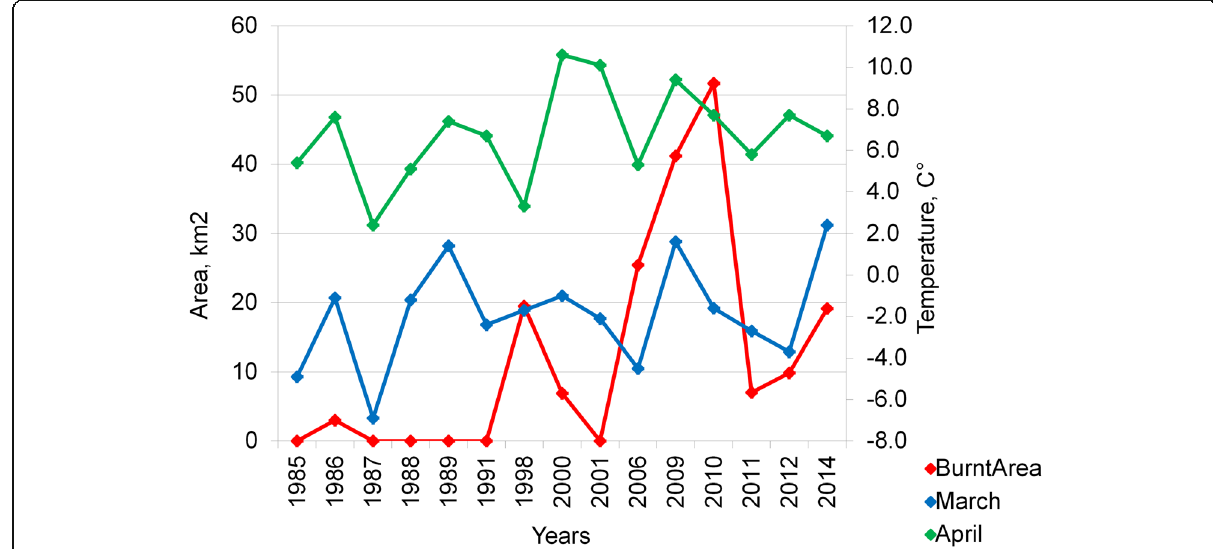
Fig. 7 Burnt area and mean temperatures: March and April are mean March and April temperatures in the investigated years